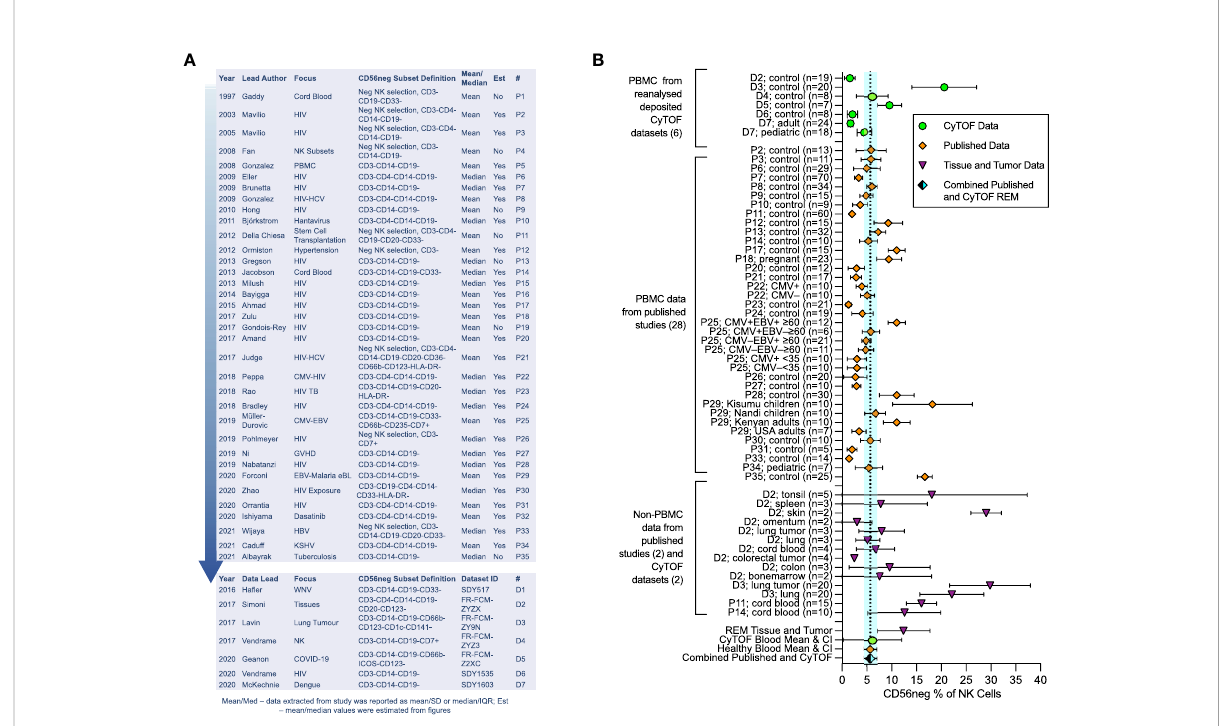
FIGURE 1 Meta-analysis of CD56neg subset frequency in NK cells from published studies and deposited datasets. Results from the meta-analysis of published and extracted data from CyTOF datasets on CD56neg NK cells. (A) 35 papers met the minimum CD56neg NK cell de fi nition and